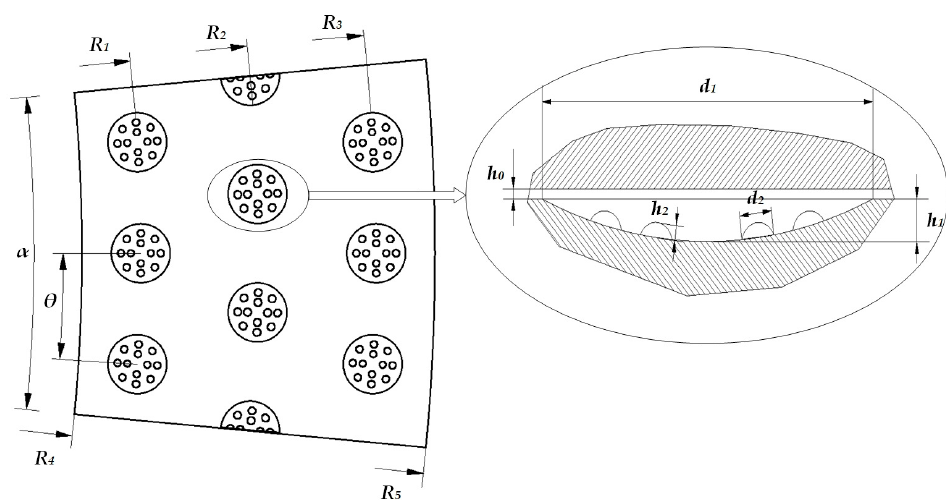
Figure 2. Fan-shaped fluid domain model of composite bionic micro-texture and circumferential, longitudinal sectional view of the single circular pit.